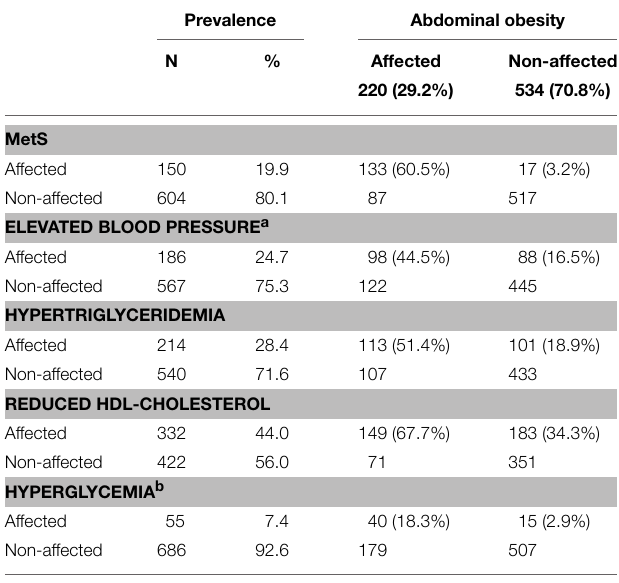
TABLE 1 | Prevalence of metabolic syndrome and its component risk factors per abdominal obesity status among genotyped subjects from the Quebec Family